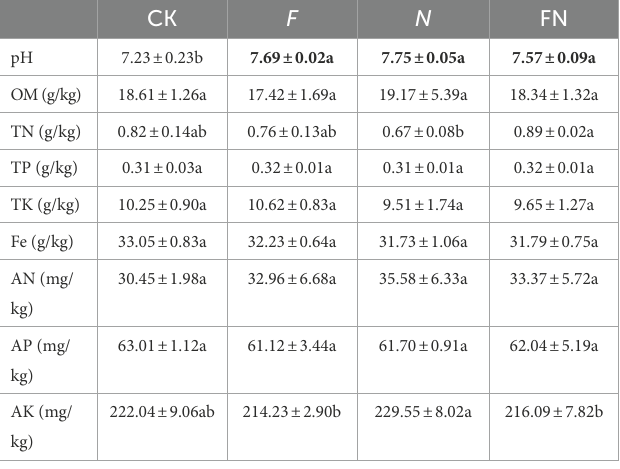
TABLE 1 The effects of different microbial inoculants on soil